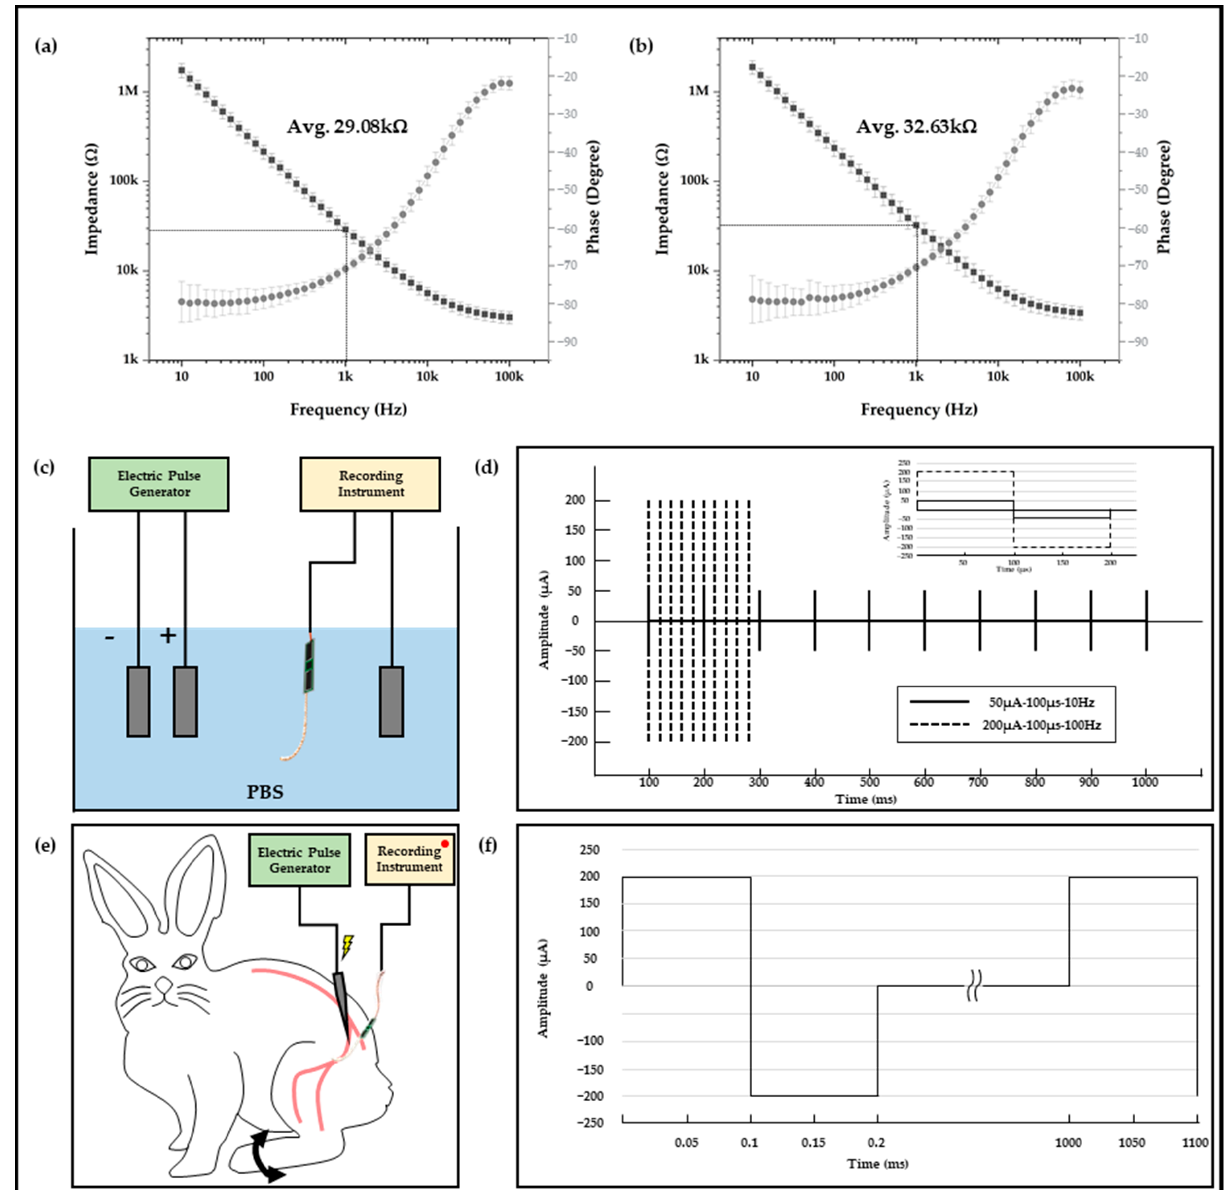
Figure 3. The results of impedance measurements of ( a ) neural electrode for in vitro experiment and ( b ) neural electrode for in vivo experiment. Electrophysiological experiment setup and stimulation parameters. ( c ) In vitro experiment setup in PBS, ( d ) a couple of stimulation parameters, ( e ) in vivo experiment setup with New Zealand white rabbit, and ( f ) in vivo stimulation parameters.